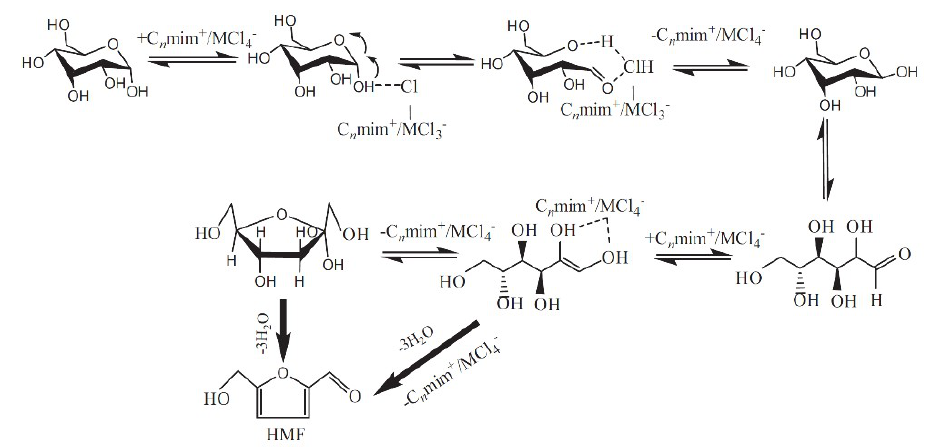
Figure 2. Interaction of metal chlorides with glucose to produce HMF in C n MIM/MCl 4 ( n = 4, 1- n -butyl-3-methylimidazolium, [BMIM]Cl; M = Cr, Al and Fe) [35].